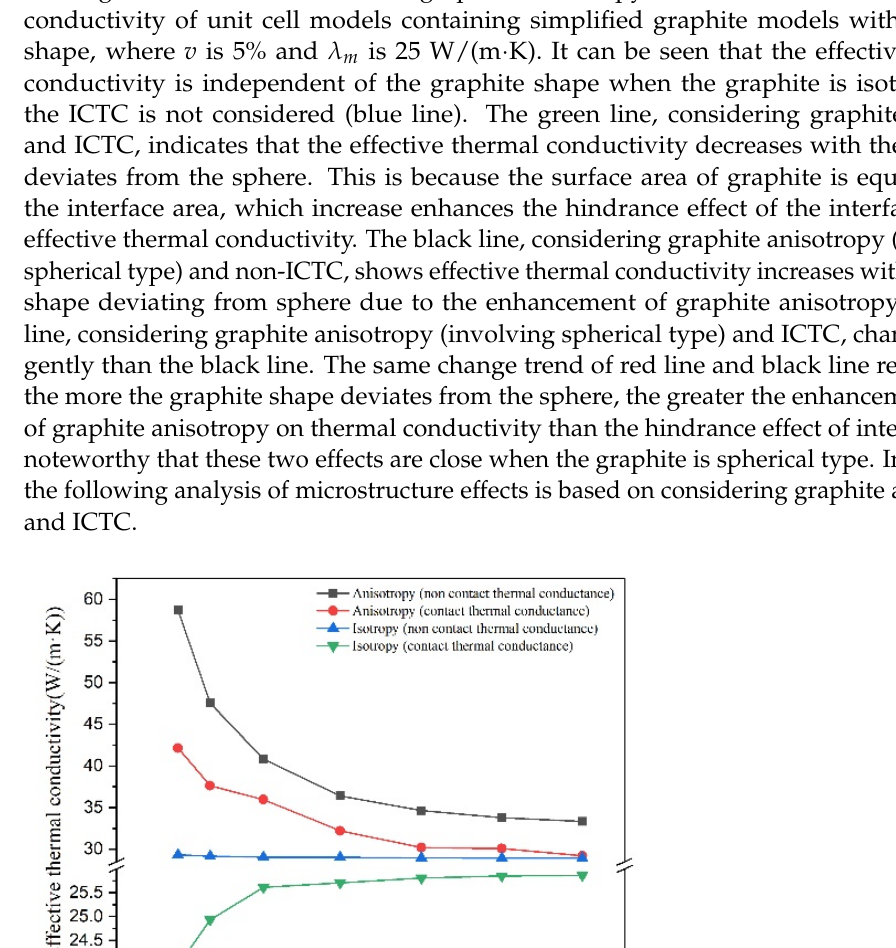
= 25 W/(m·K) (cid:3040)